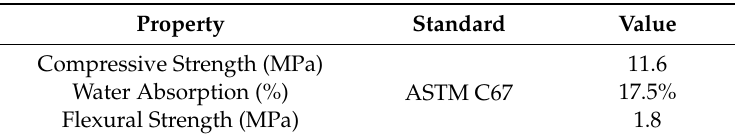
Table 1. Basic properties of the bricks used.